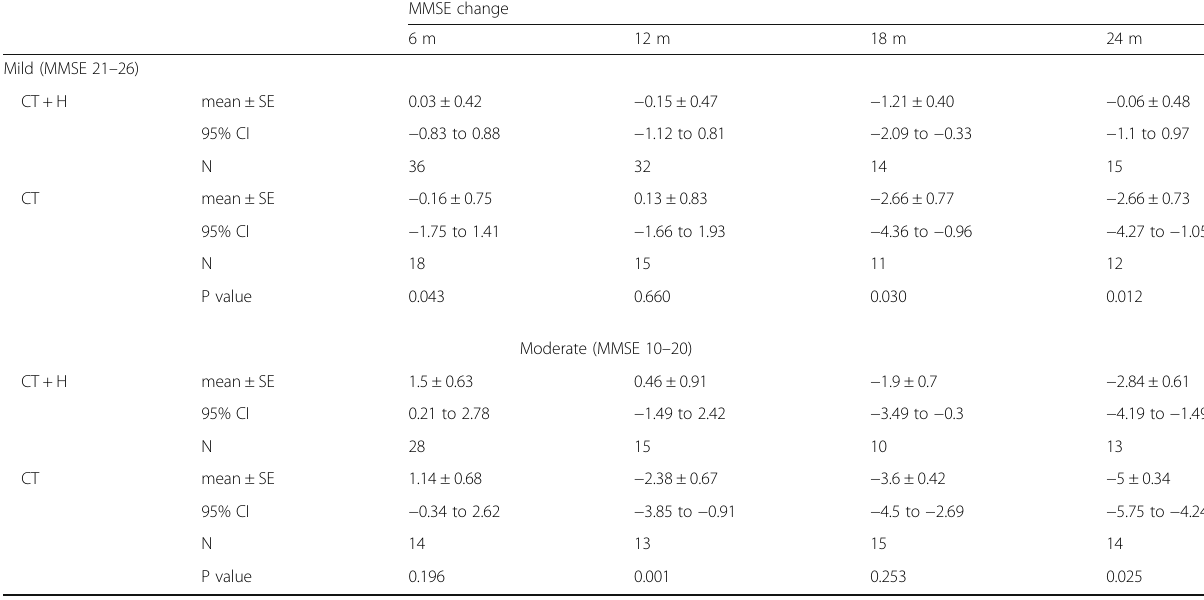
Table 3 MMSE change among AD patients with different